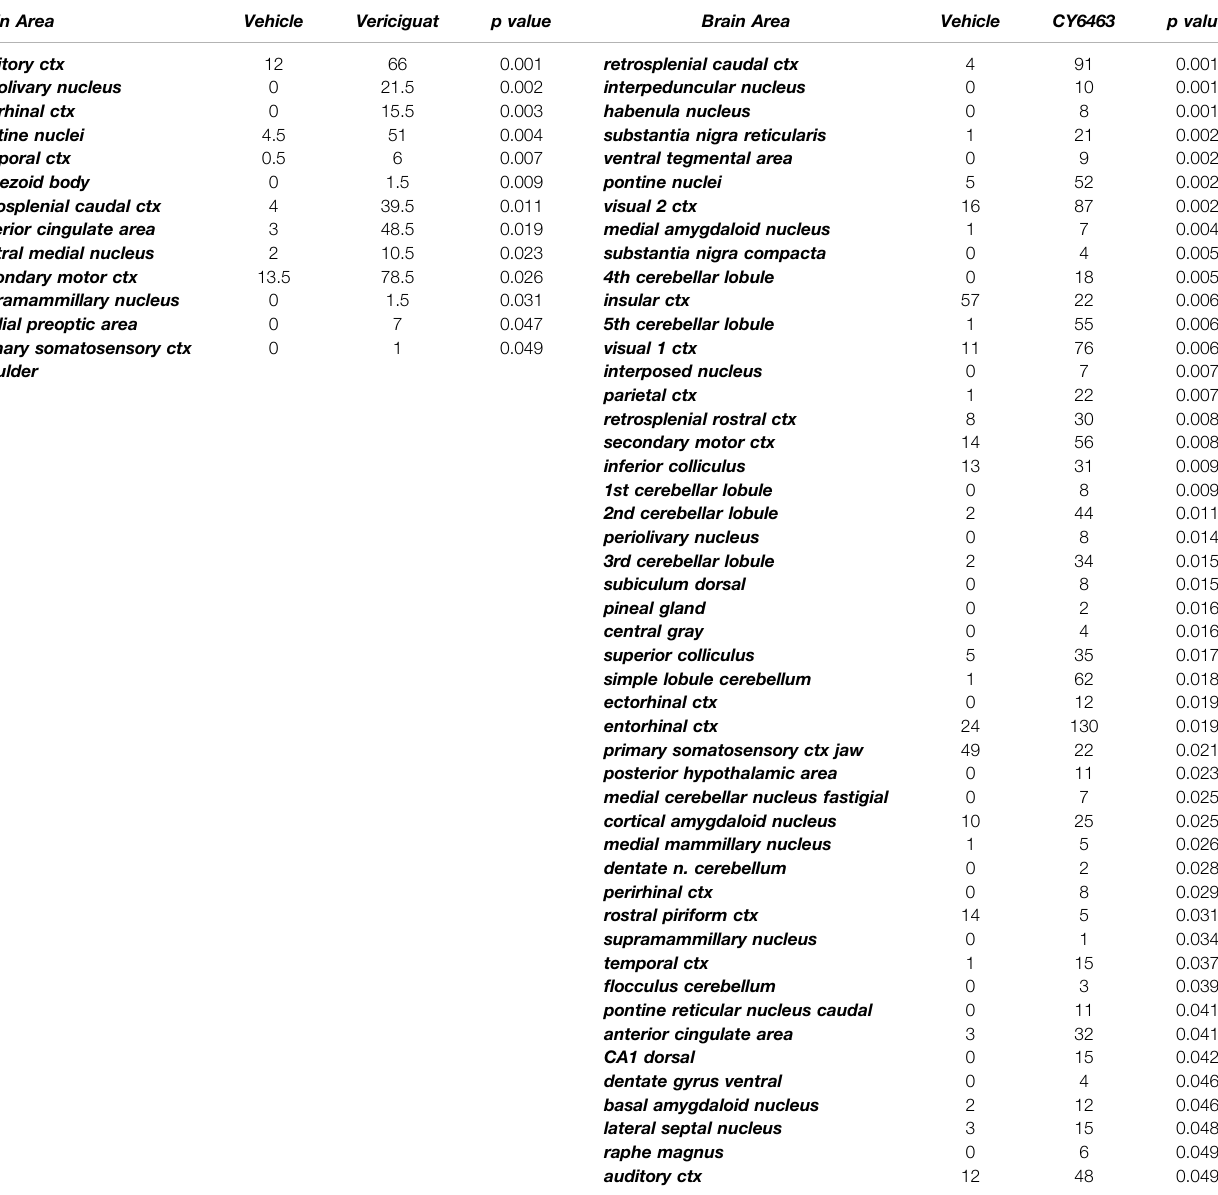
TABLE 2 | Median number of positive voxels activated for CY6463 vs. vehicle and vericiguat vs. vehicle. Brain Area Vehicle Vericiguat p value Brain Area Vehicle auditory